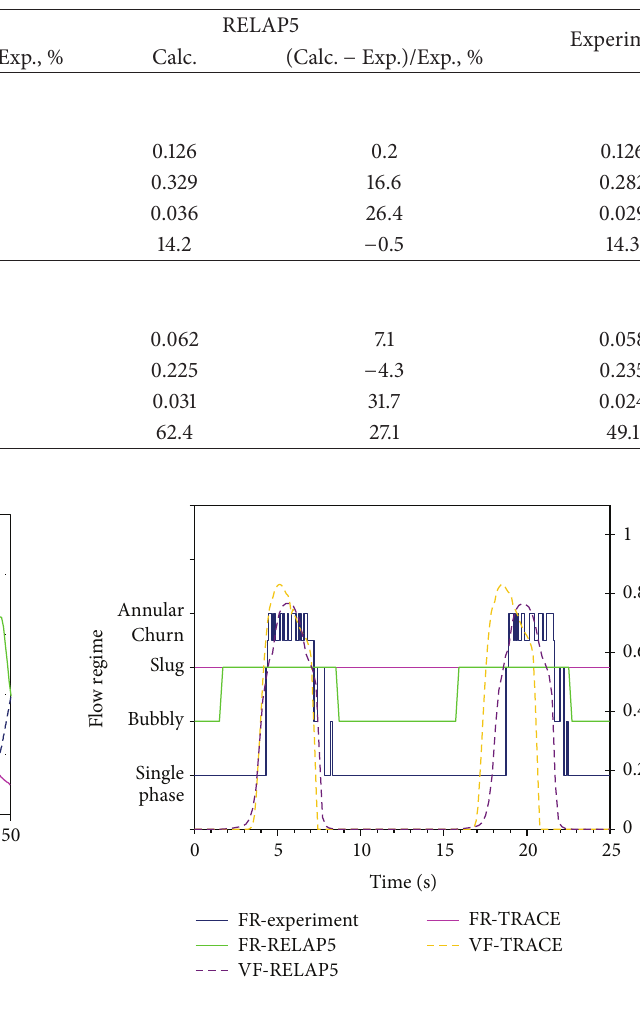
Figure 7: Test I-2: riser flow regime (FR) and void fraction (VF) in the section for visual observation.